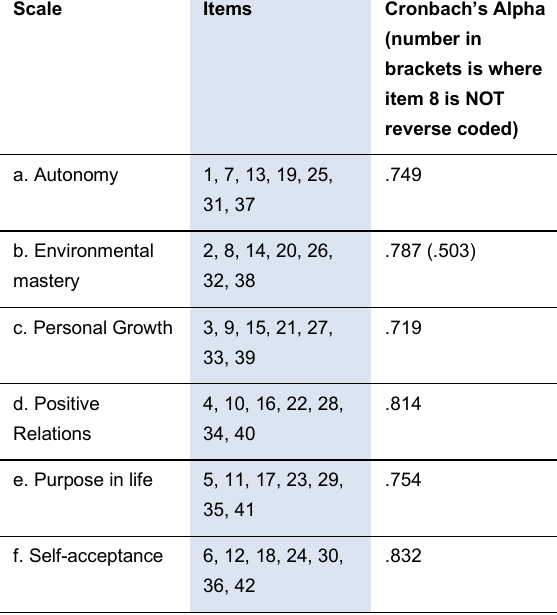
Table 1: Internal consistency of Ryff